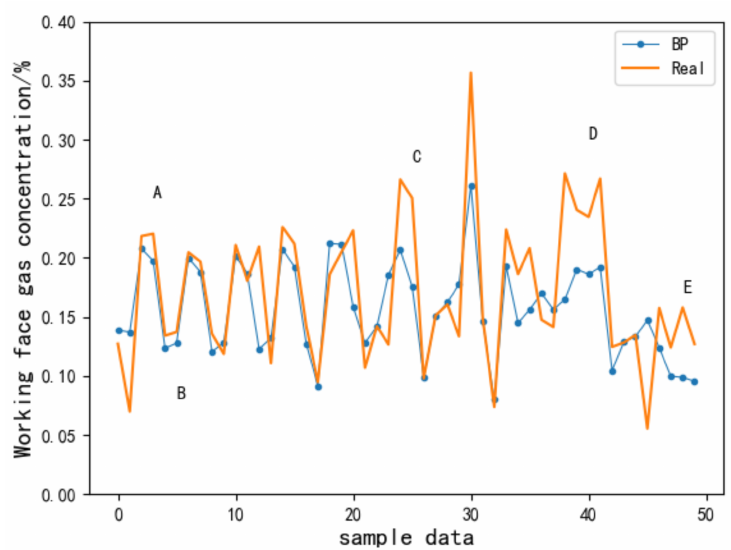
Figure 10. Prediction fitting based on PSO-Adam-BP.